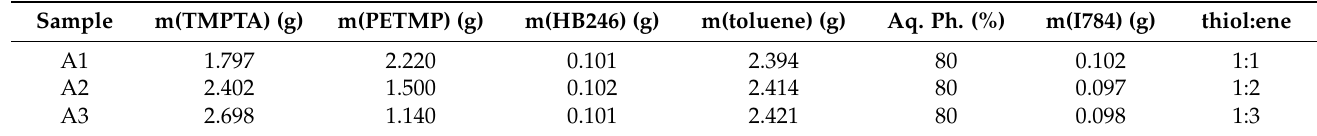
Table 1. Preparation of PETMP-co-TMPTA polyHIPE microspheres.